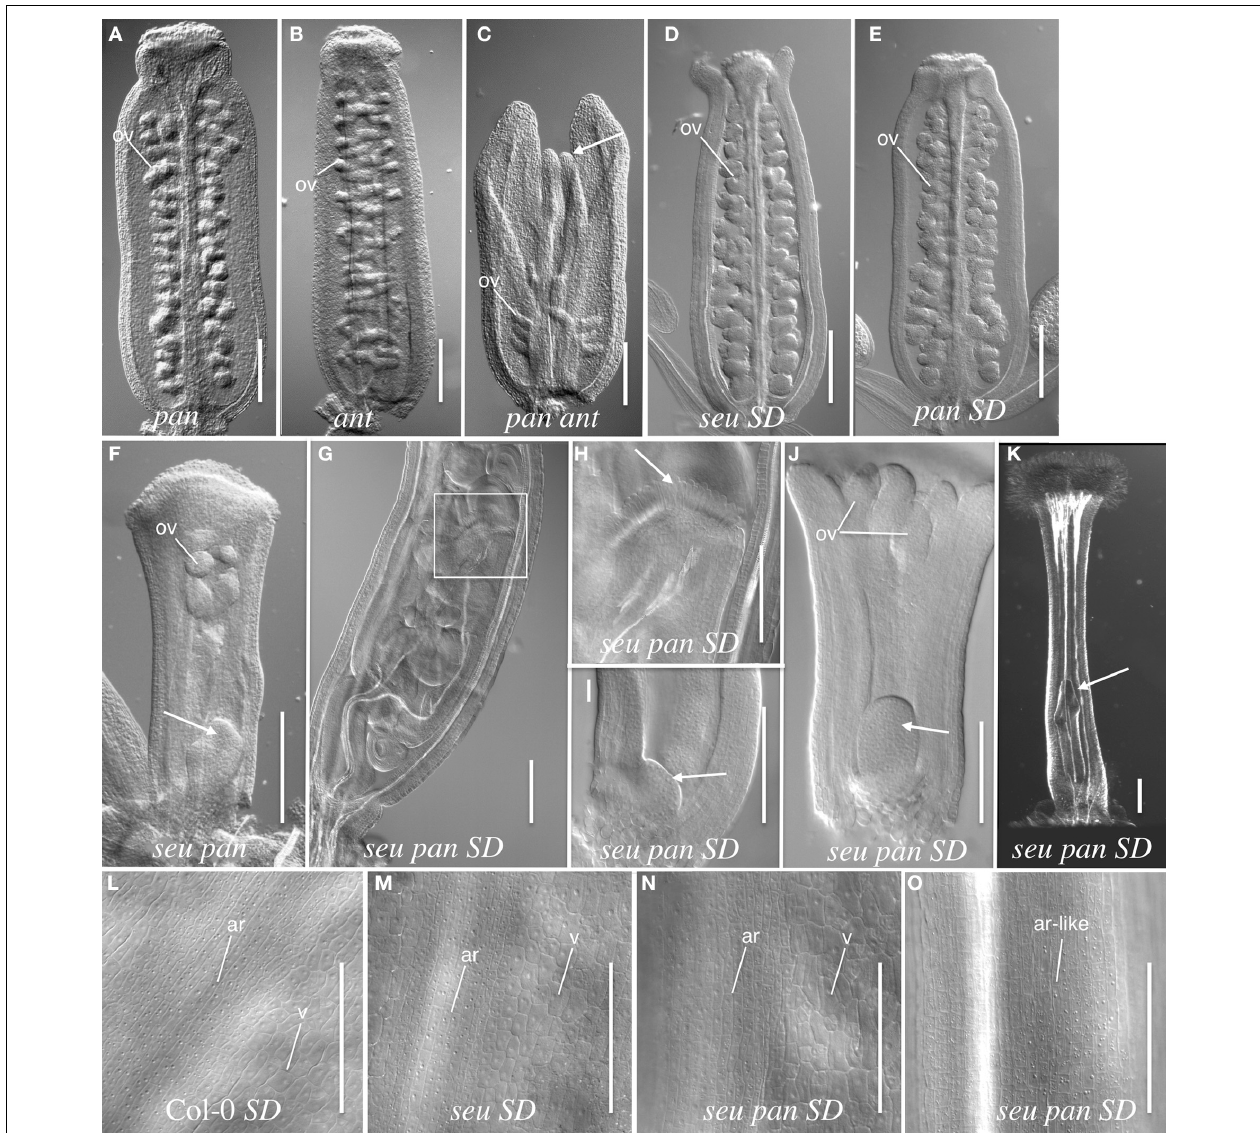
FIGURE 2 | Gynoecial and ovule phenotypes in pan ant and seu pan double mutants. (A) pan 057190 single mutant gynoecium. (B) ant single mutant gynoecium. (C) pan 057190 ant double mutant gynoecium displays reduced ovule number, a reduction in the growth of the medial domain (arrow) and enhanced splitting of the gynoecium. Arrow in panel (C) indicates the apical extent of the medial domain of the carpel. (D) seu single mutant gynoecium grown under short-day (SD) conditions shows slight splitting of the gynoecial apex. (E) SD-grown pan single mutant displays near wild type phenotype. (F) seu pan 057190 double mutant (long-day conditions) displays a “fifth whorl” structure inside the gynoecium (arrow). (G) SD-grown seu pan 057190 double mutant displays a well-developed “fifth whorl” structure inside the gynoecium. (H) A higher magnification image of the boxed area shown in panel (G) . Arrow indicates the stigmatic tissue at the apex of second gynoecium developing within the primary gynoecium. (I) SD-grown